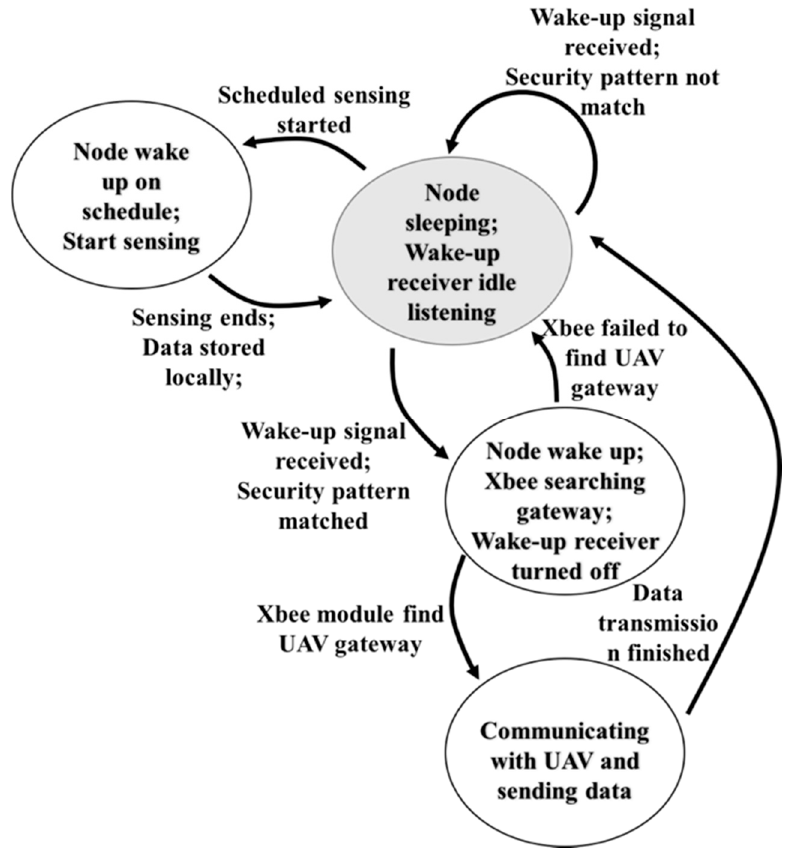
Figure 3. State and action diagram of the ground sensor nodes and the unmanned aerial vehicle (UAV).